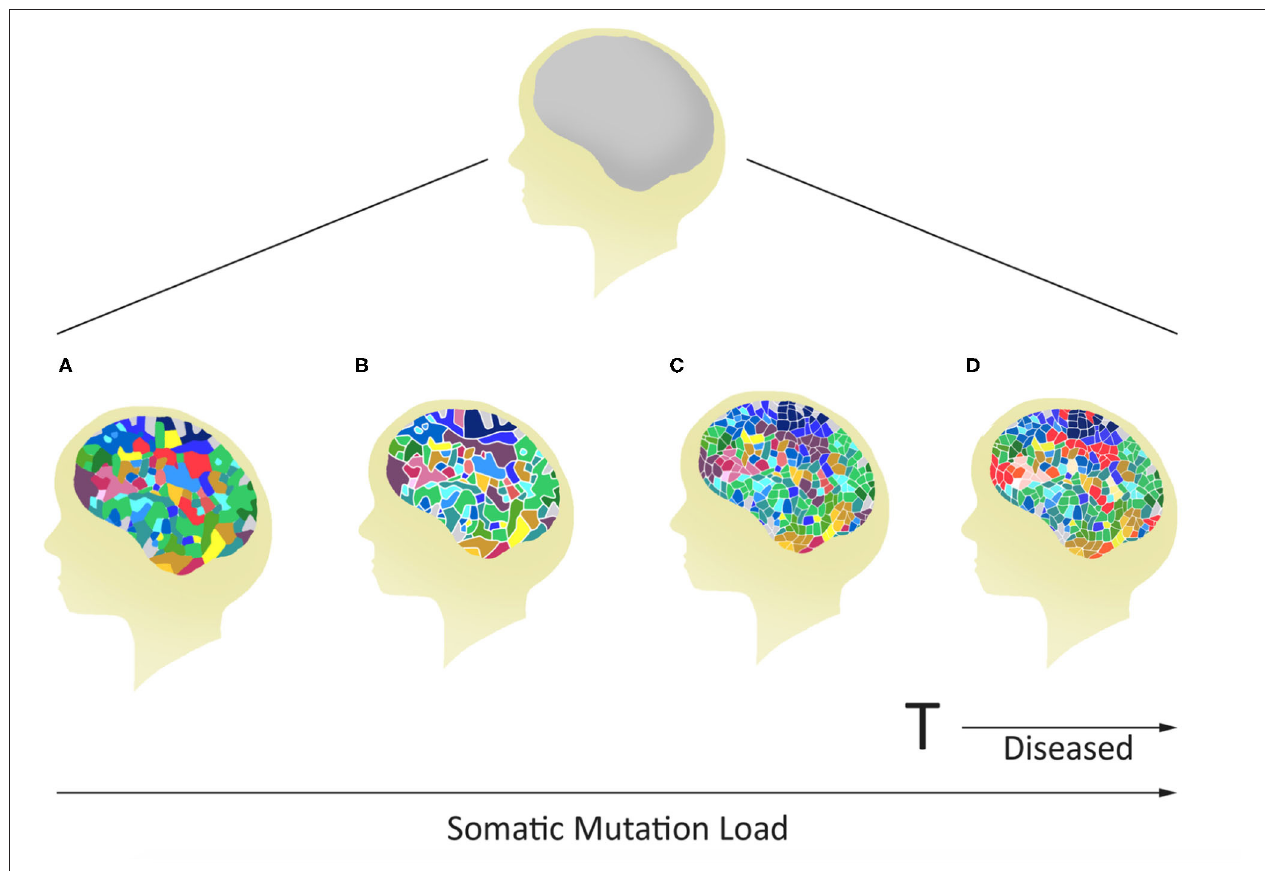
FIGURE 2 | Potential for variable mosaicism in an individual brain based on differences in postzygotic somatic de novo mutations during development. The outcome will make every brain unique, some below (A–C) , and others above (D) a genomic threshold for the development of a mental disease.